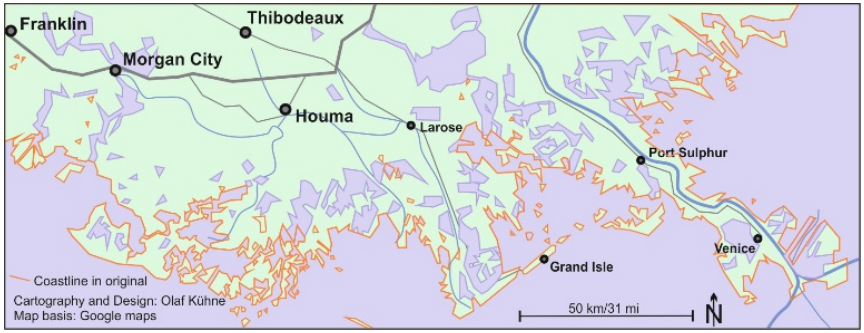
Figure 2. Generalized cartographic representation according to Google Maps (retrieval date: May 15, 2022; [53]). Remarkable here is the strong divergence between the specifically designated coastline and the land areas represented using area signatures (own representation, as in [54]).